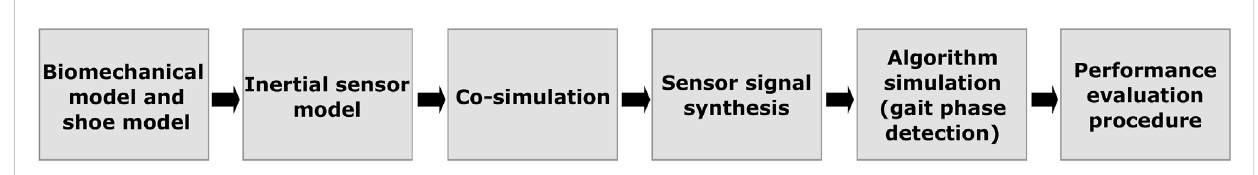
FIGURE 2 Co-simulation framework overview. Inertial sensor model instances are distributed across biomechanical and shoe models. Motion data is used to co-simulate the models and synthesise inertial sensor data. Based on the various simulated sensors, performance of selected gait event